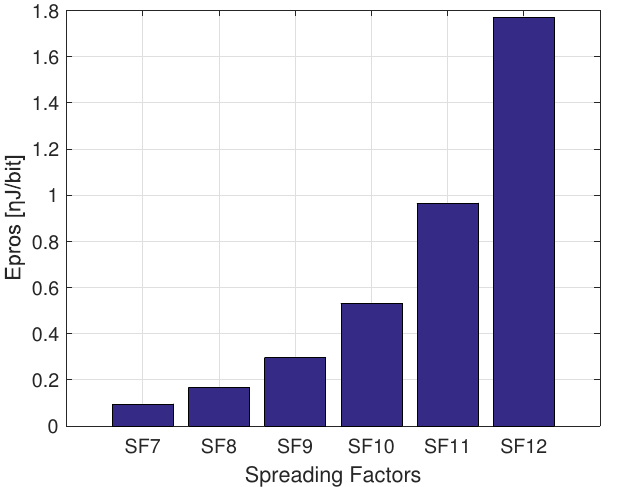
Figure 7. The distribution of the consumed energy for processing when transmitting a PL = 30 Bytes using different SFs setting with CR